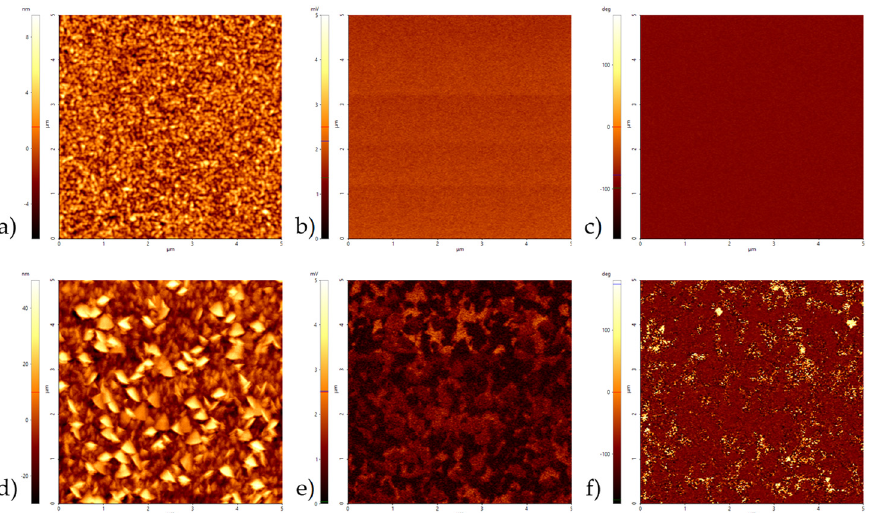
Figure 7. PFM results (area 5 µm × 5 µm) of 2.5 µm AlScN, deposited with S u = 60% pulse mode, at radial positions 25 mm ( a – c ) and 100 mm ( d – f ): topography ( a , d ), piezoelectric amplitude ( b , e ) and piezoelectric phase ( c , f ).